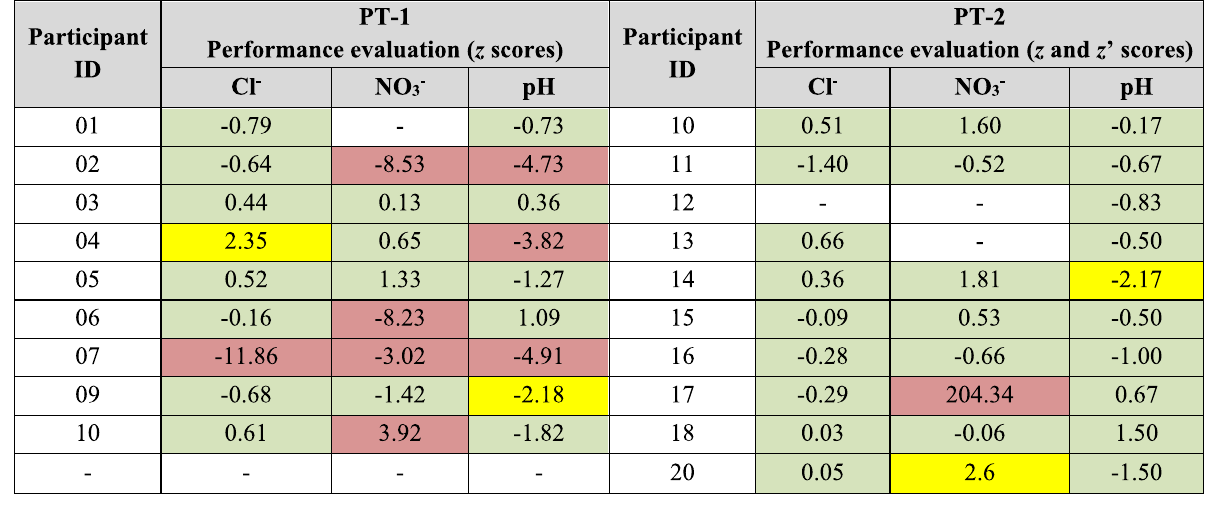
Table 2. Performance evaluation results for PT-1 and PT-2 (green = acceptable results, yellow = questionable results and red = unacceptable